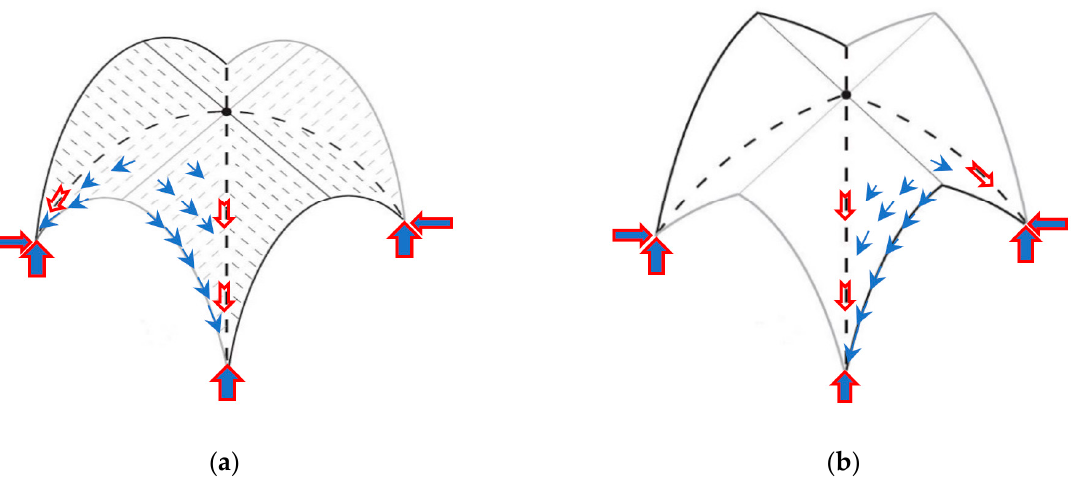
Figure 5. Force transmission from the vault to supporting columns (piers) for ( a ) groin vault, ( b ) rib